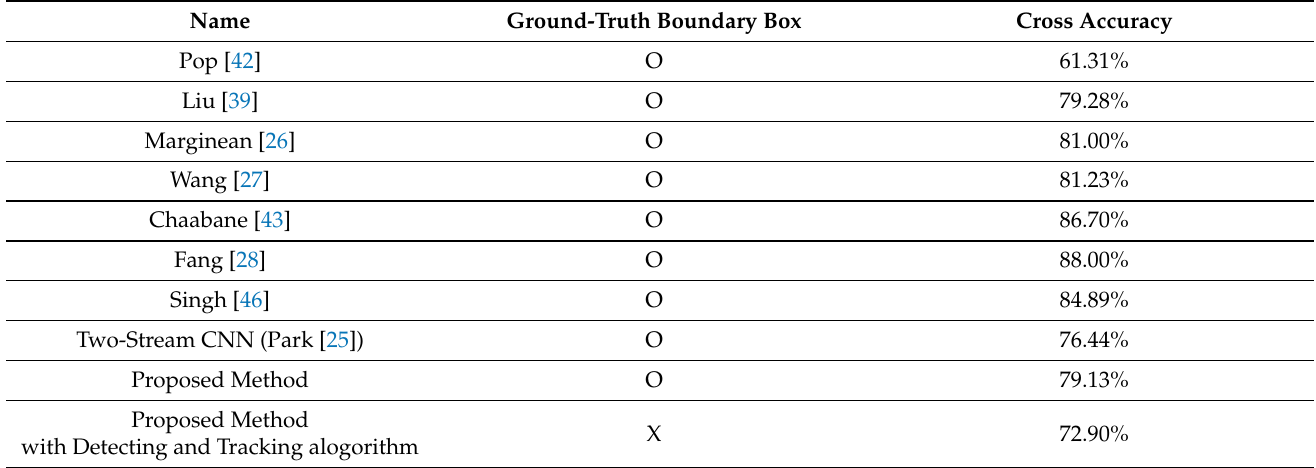
Table 11. Comparison of pedestrian cross-attribute recognition for state-of-the-art in single-task learning algorithm with the JAAD testing